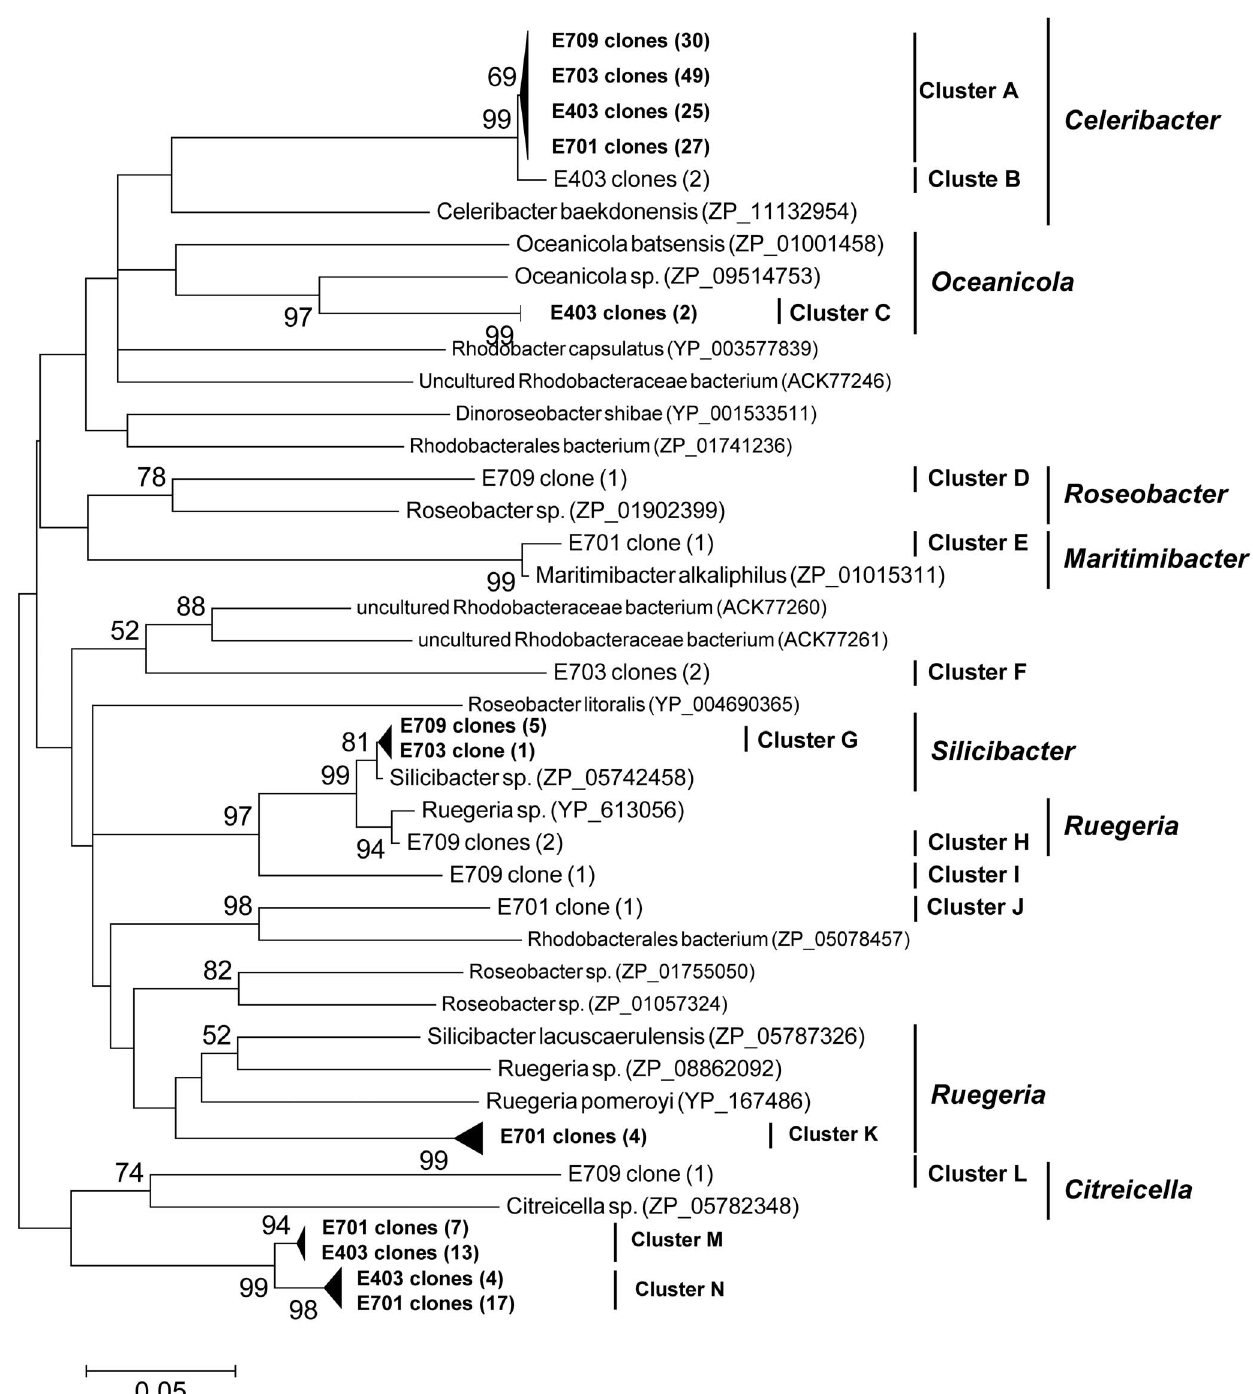
Figure 4. Neighbor-joining phylogenetic tree based on partial g5 amino acid sequences (ca. 250 aa) showing the phylogenetic diversity of g5 in the northern South China